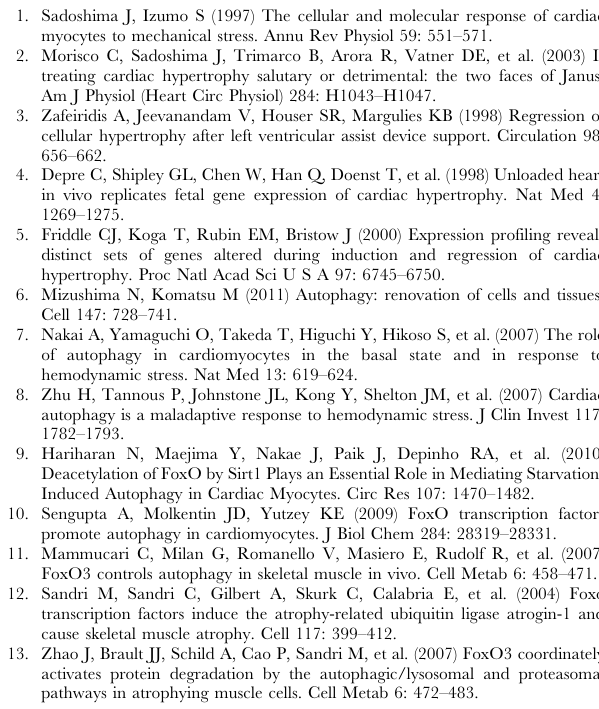
Figure S1 Distribution of cardiomyocyte cell size in mice after TAC and DeTAC. C57BL/6 mice were subjected to pressure overload caused by thoracic aortic constriction for 1 week (1W TAC), followed by cardiac unloading by removal of the constriction for 1 week (1W DeTAC). Size distribution of cardiac myocyte cross- sectional area was measured from at least 50 cells from 3 different animals in each group. Figure S2 Characterization of Tg-FoxO1. Cardiac phenotype of Tg-FoxO1 (line # 8). Tg-FoxO1 and non-transgenic (NTg) mice were euthanized at the age of 3 months. A) Pictures of NTg and Tg-FoxO1 (line # 8) hearts. Each graduation in the scale below = 1 mm. B) Left ventricular weight (LVW)/body weight (BW) (mg/g). n= 32. C,D) LV cardiomyocyte cross sectional area. Wheat germ agglutinin staining was performed and average cardiomyocyte cross sectional area was obtained in NTg and Tg- FoxO1 hearts. Figure S3 Stimulation of autophagy in Tg-FoxO1 hearts. Tg- FoxO and NTg mice were treated with chloroquine (Chq, 10 mg/ kg, ip), and euthanized 4 hours after treatment. A. Immunoblots